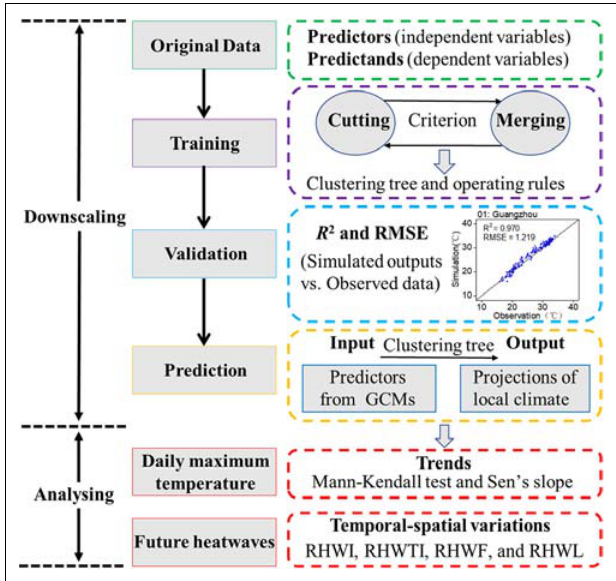
FIGURE 1 | The framework of the developed stepwise-clustered simulation